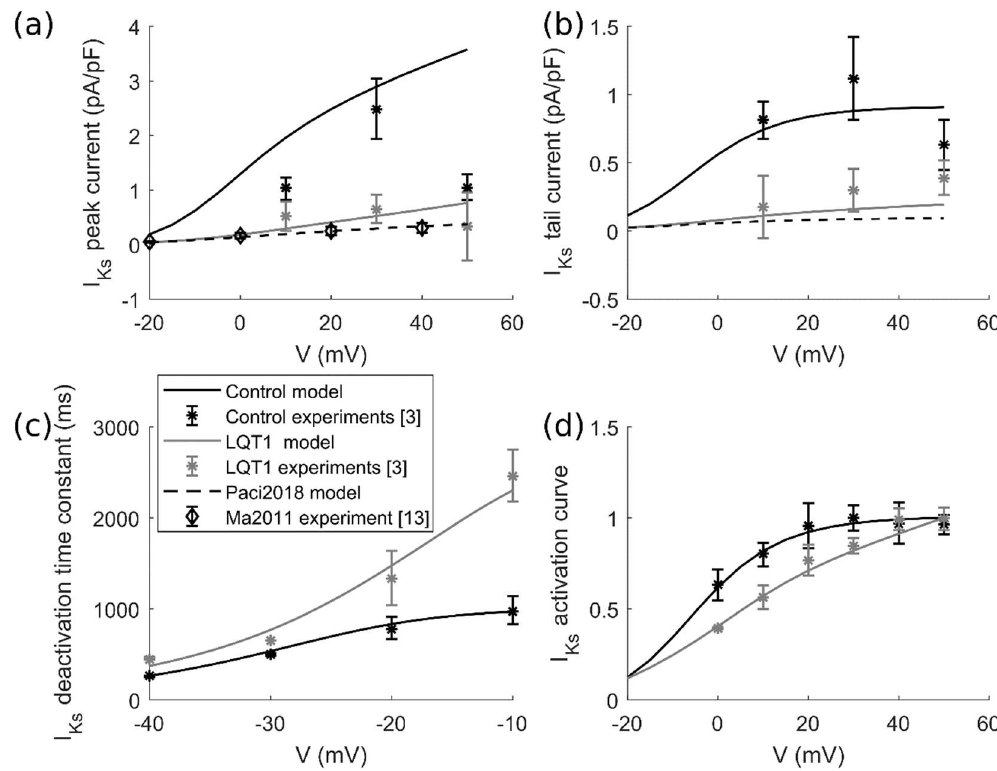
Figure 13. Fitting of the I Ks experimental data from Moretti et al. [3]. The black stars and curve represent the Moretti et al. control data [3] and fitting, respectively. The grey stars and curve represent the Moretti et al. mutant data [3] and fitting, respectively. The diamonds and the dashed curve represent the I Ks measurements from Ma et al. [13] and the I Ks simulated by the Paci2018 model [20]. ( a ) I Ks peak current (a zoom on the Paci2018 I Ks peak current is reported in Figure S7). ( b ) I Ks tail current. ( c ) Voltage dependence of I Ks deactivation kinetics. ( d ) Voltage dependence of I Ks activation.